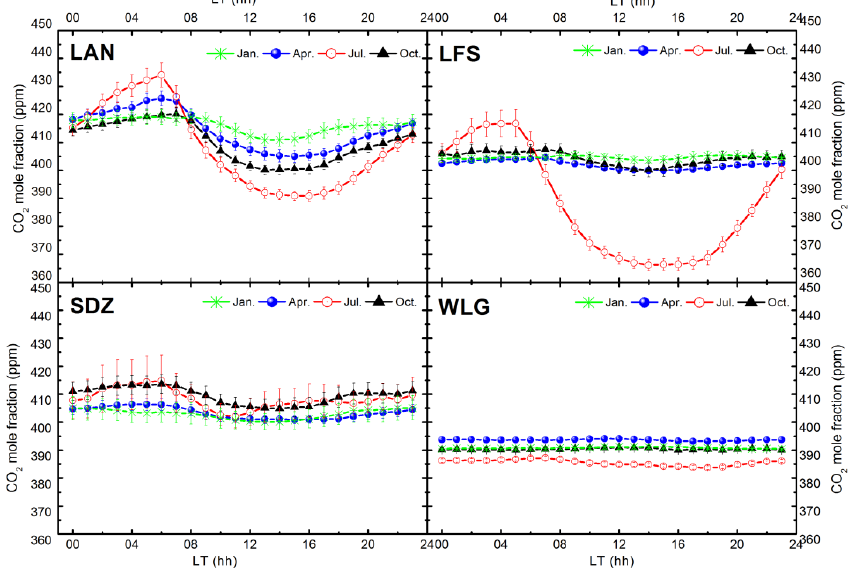
Fig. 3. Mean diurnal variations of CO 2 mole fractions in January, April, July, and October. Error bars indicate confidence intervals of 95%. LAN, LFS, and SDZ data are sampled at 10ma.g.l., while WLG data are sampled at 80ma.g.l. the four stations. The mean standard deviations for hourly CO 2 concentration are 9.5, 21.5, 15.9, and 12.7 ppm